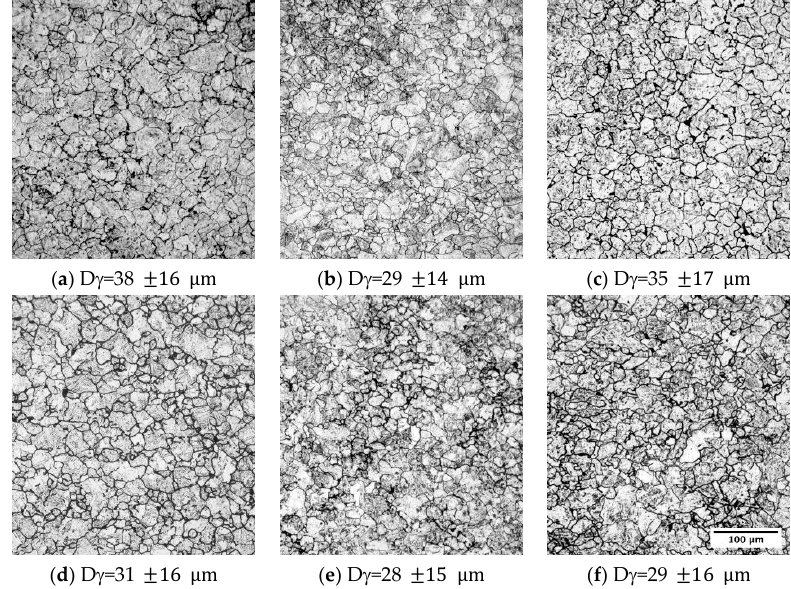
Figure 13. Two-pass reduction of 15% at 1150 and 1100 °C for ( a ) H4, ( b ) H8 and ( c ) L8; three pass reduction at 1150, 1100, and 1050 °C for ( d ) H4, ( e ) H8 and ( f ) L8. Metals 2019 , 9 , x FOR PEER REVIEW